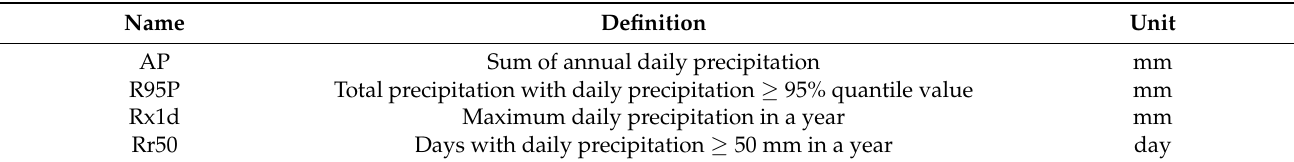
Table 2. Definition of extreme rainfall indices.